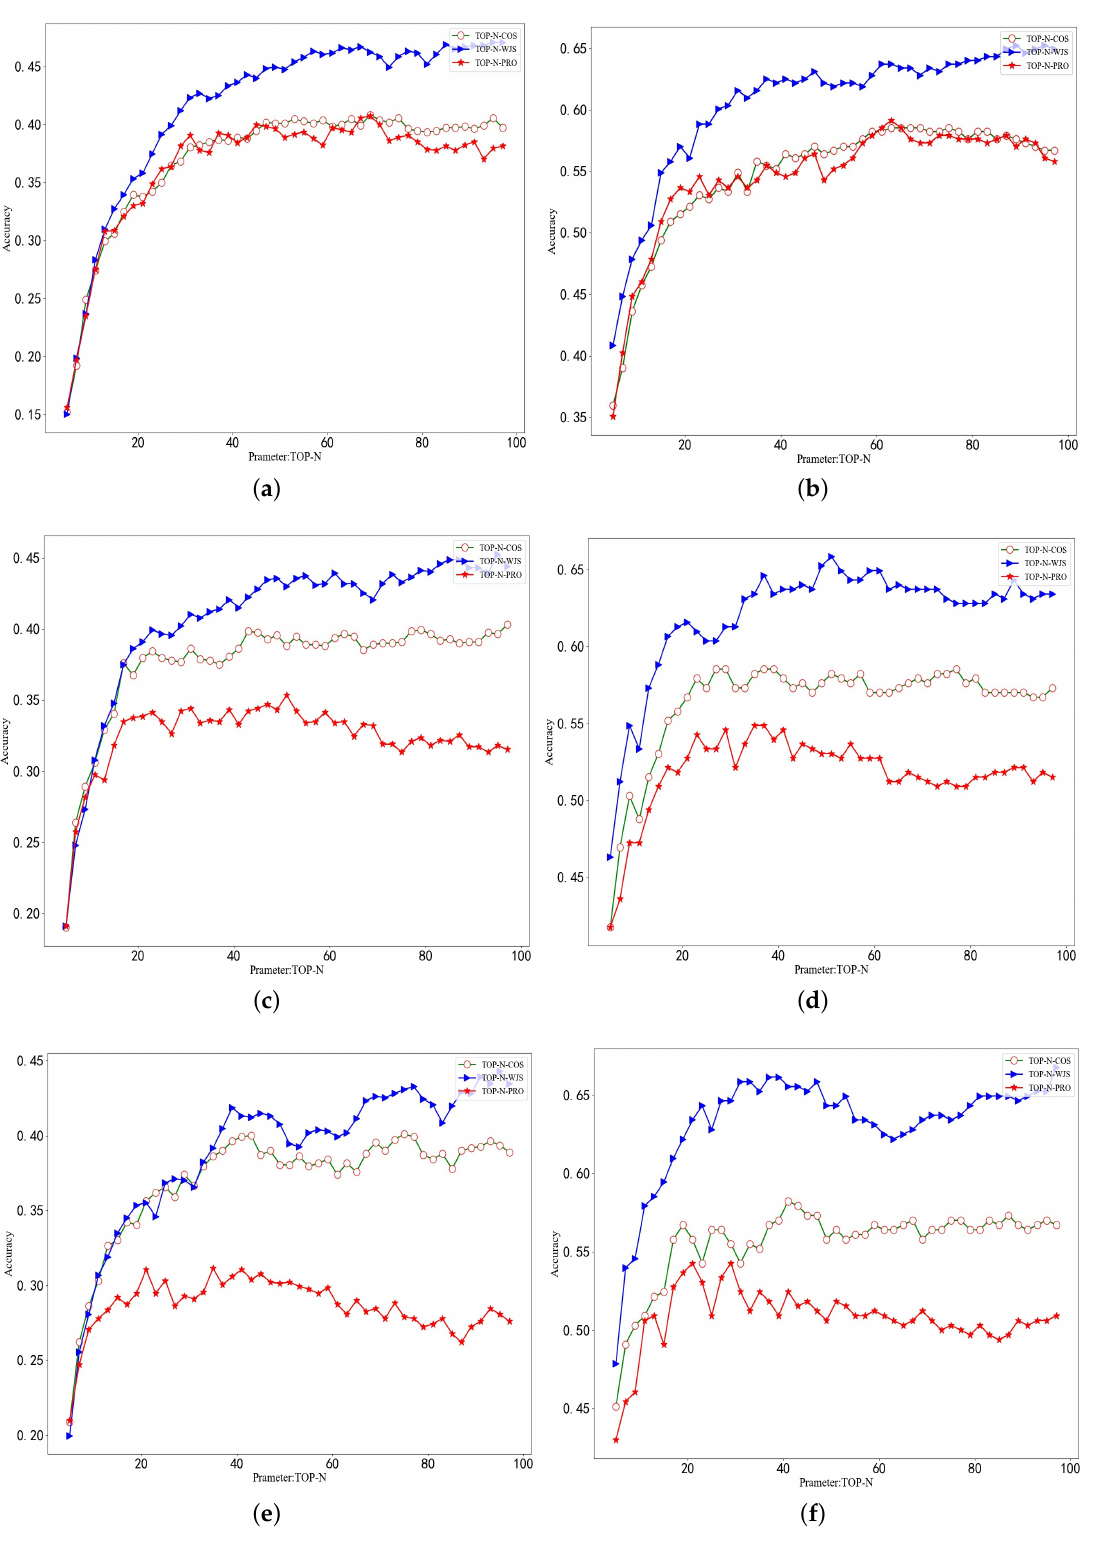
Figure 2. Comparing TOP-N-COS, TOP-N-PRO and TOP-WJS by accuracy vs. TOP-N. ( a , c , e ) D c ( b , d , f ) D g vs. D g 2 1